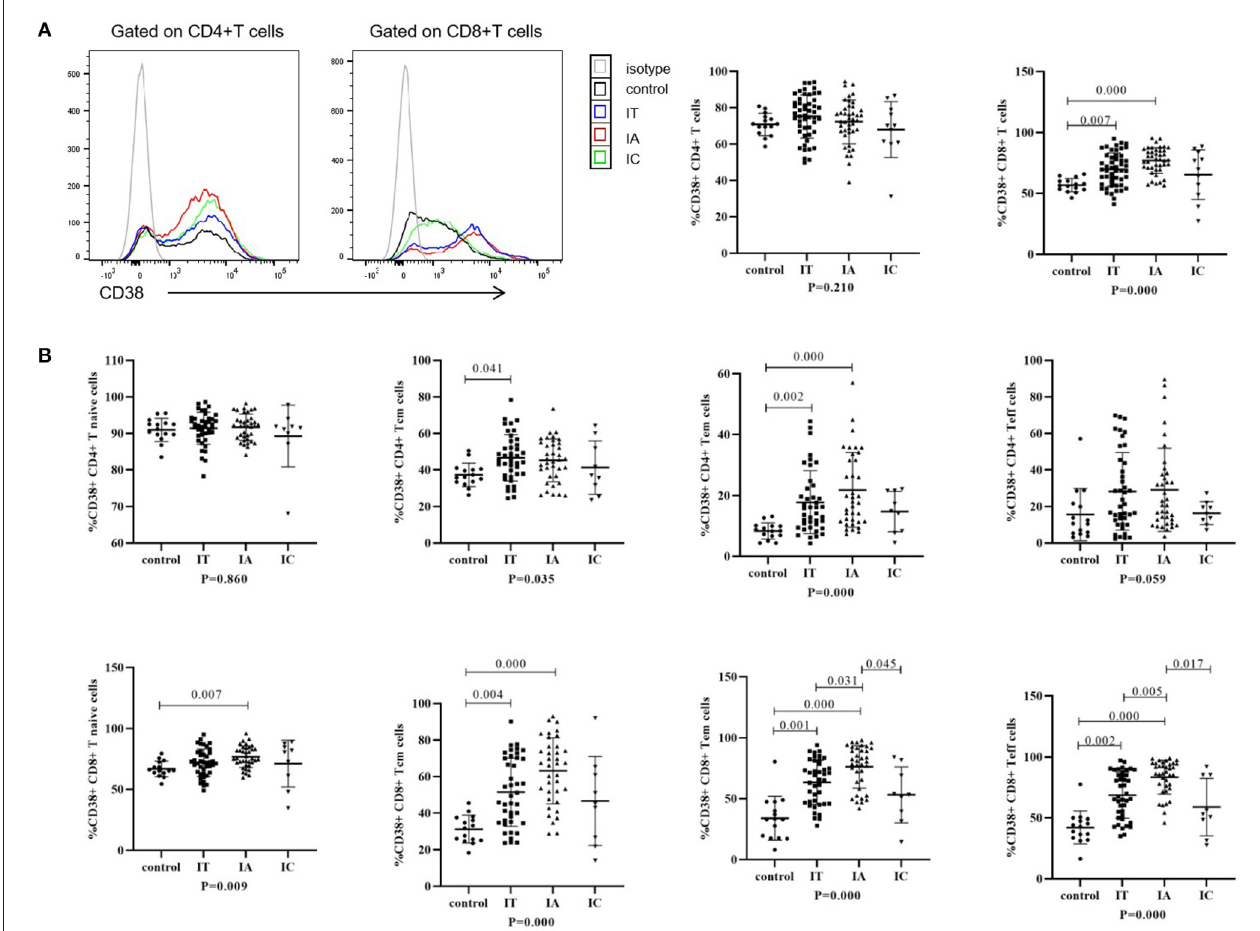
FIGURE 2 | Phenotypes of T cells in different clinical phases. (A) Representative flow histogram plots (left) and frequencies (right) of CD38 on CD4 + T cells and CD8 + T cells. (B) Frequencies of CD38 on CD4 + and CD8 + memory T subsets. The p-values below the abscissa represent the results of the Kruskal–Wallis test of the four groups. Numbers above the lines represent the p -values of the multiple pairwise comparison with statistical significance. A value of p < 0.05 is considered statistically